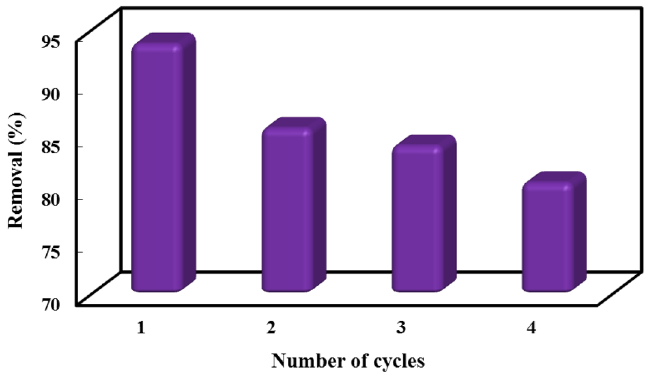
Figure 8. Reusability studies for the adsorption of MB dye onto Fe 3 O 4 @MOF-PAMAM.